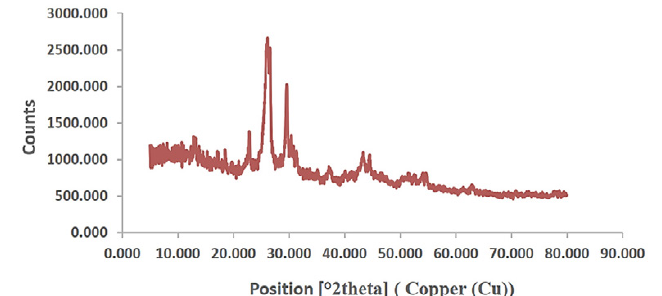
O nanocomposite [15] 2 3